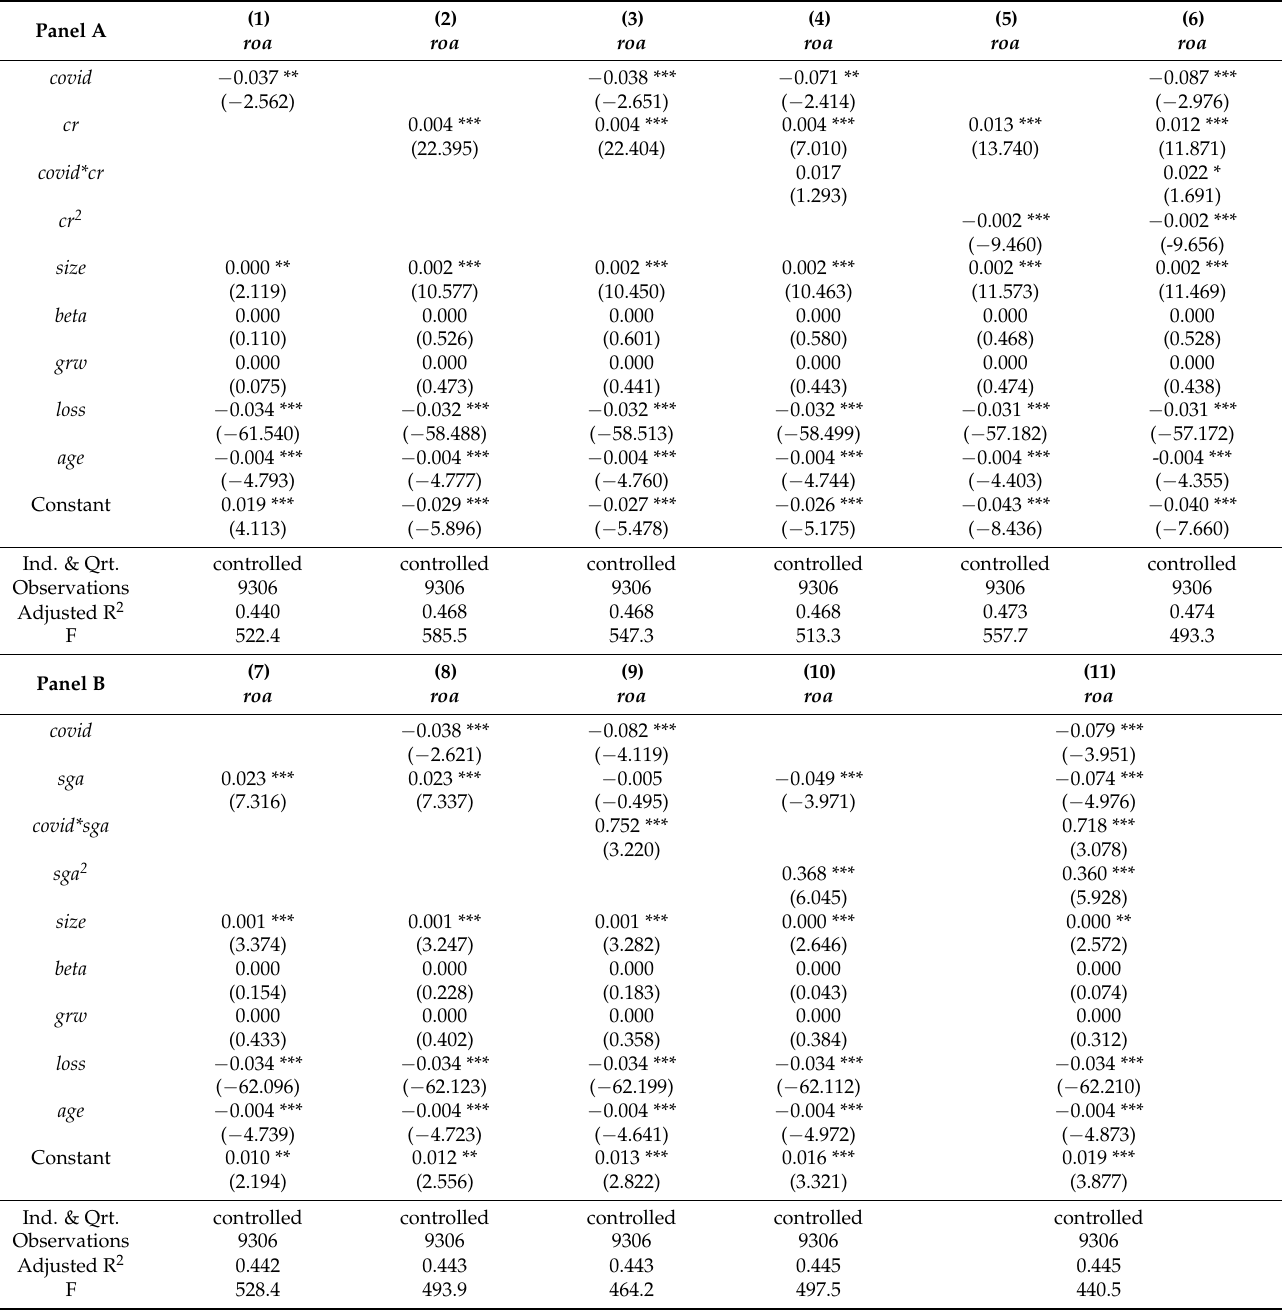
Table 5. Regression results for